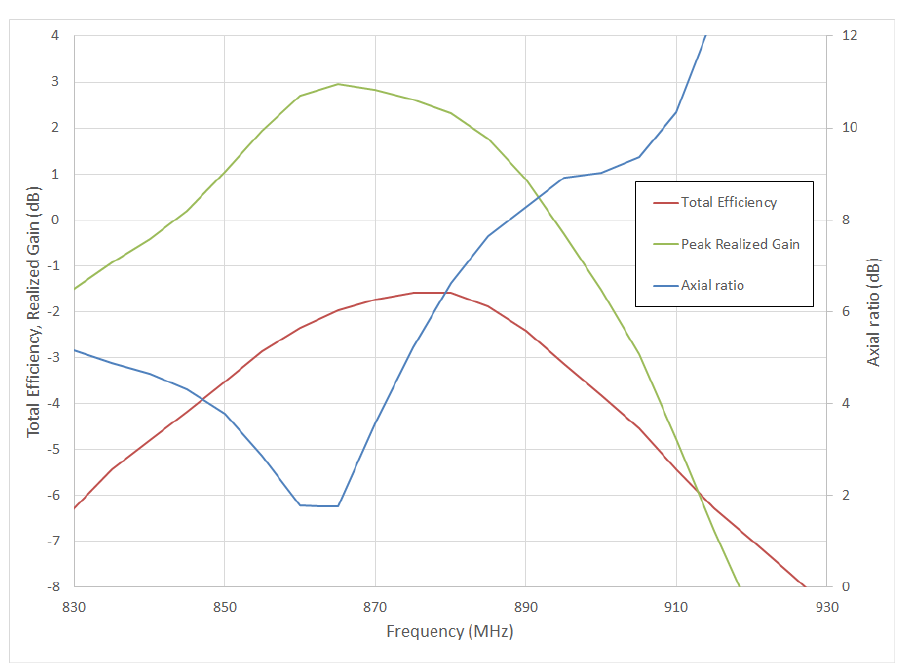
Figure 10. Total efficiency, peak RHCP Gain, and broadside axial ratio versus